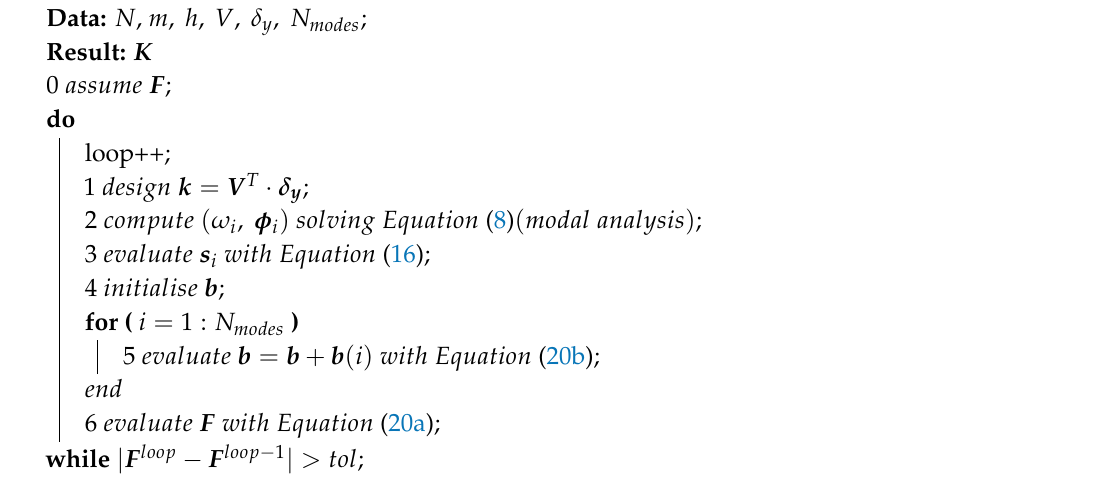
Algorithm 2: Pseudocode for P 3 and P all